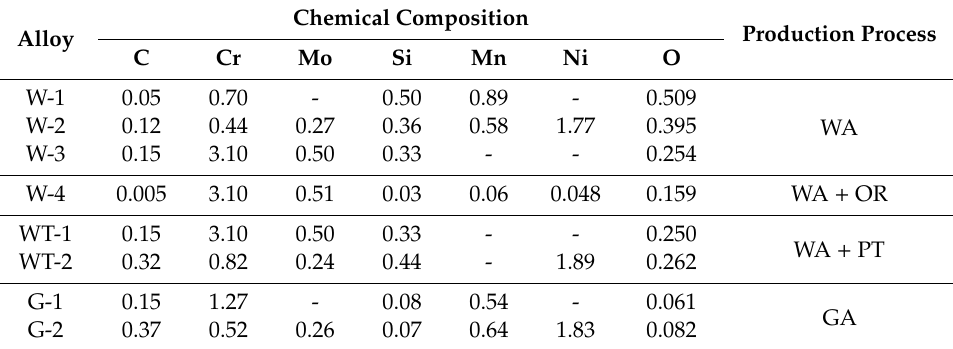
Table 1. Chemical compositions (wt.%) of the investigated steels.